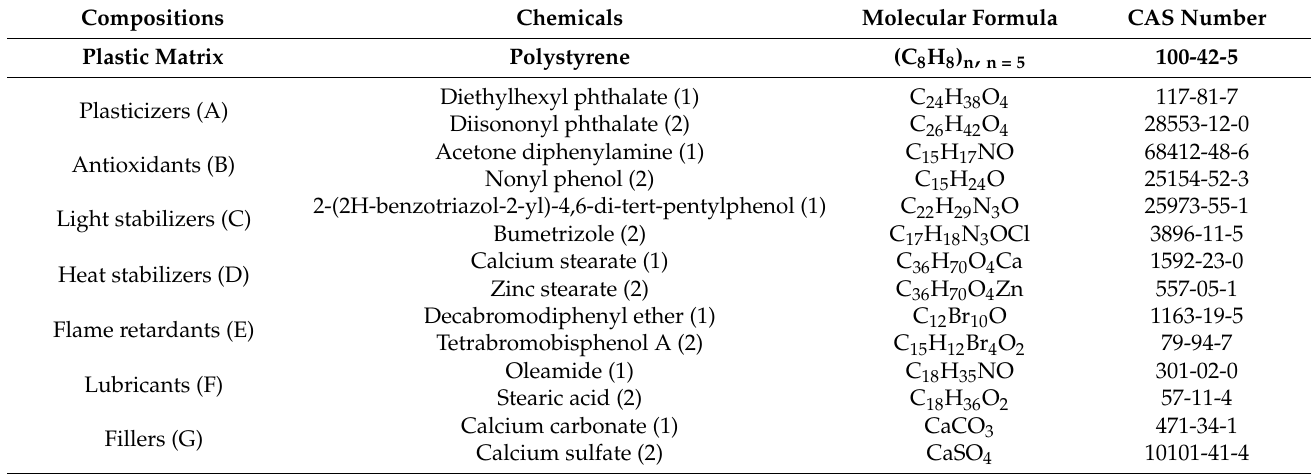
Table 1. Typical polymeric additives and their maximum and minimum